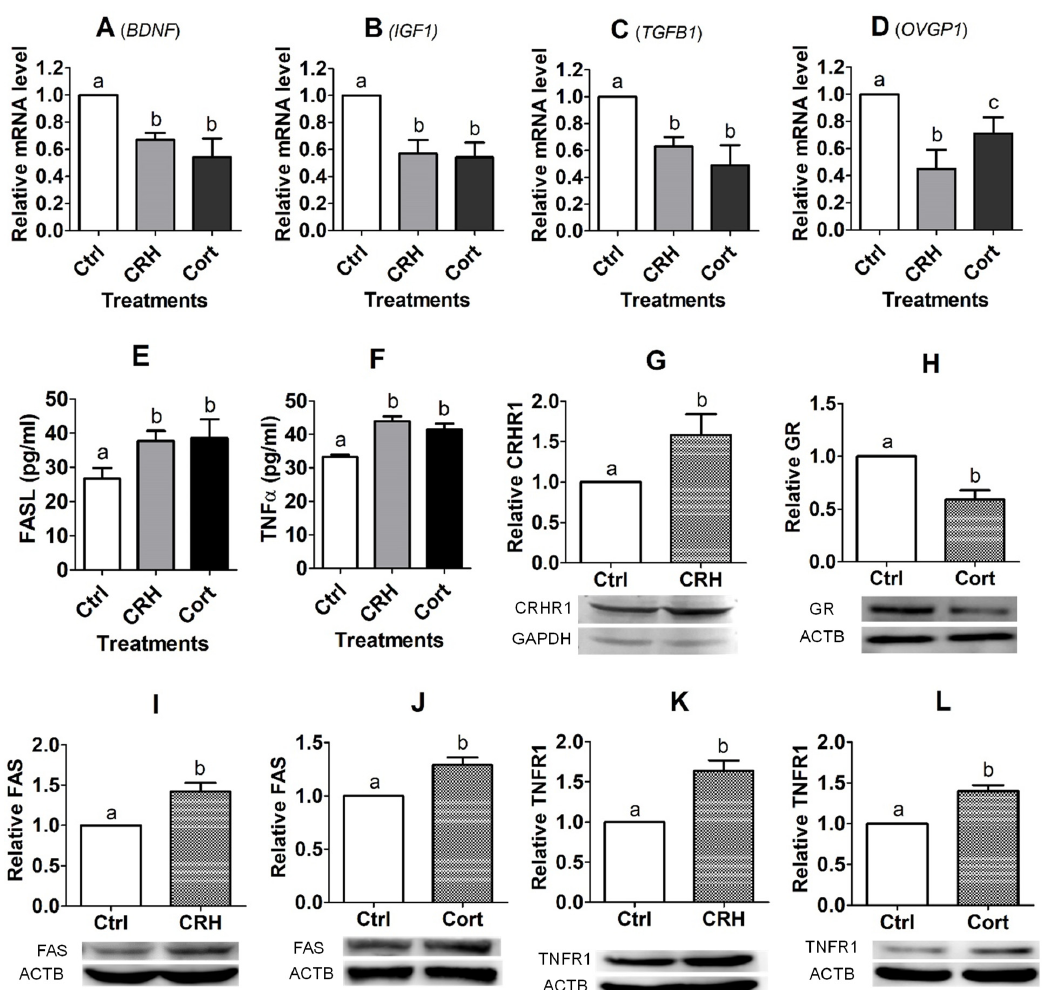
Figure 5. Effects of culture with corticotrophin-releasing hormone (CRH) or cortisol (Cort) on expression of growth factors, oviduct-specific glycoprotein (OVGP1), Fas ligand (FASL)/tumor necrosis factor (TNF) α and their receptors, and CRH/glucocorticoid receptors (GR) in pig oviduct epithelial cells (OECs). Pig OECs were cultured without (Ctrl) or with CRH (2 × 10 − 6 M) or Cort (1 × 10 − 6 M) for 48 h before examination. Graphs ( A – D ) show relative levels (RT-PCR results) of brain-derived neurotropic factor ( BDNF) , insulin-like growth factor 1 ( IGF1) , transforming growth factor β 1 ( TGFB1 ) and OVGP1 mRNAs, respectively. Graphs ( E , F ) show levels of FASL and TNF α proteins (ELISA results), respectively. Graphs ( G – L ) show relative levels of CRH receptor (CRHR1), GR, FAS and TNFR1, respectively, as revealed by Western blotting. a–c: Values with a different letter above bars differ significantly ( p < 0.05).